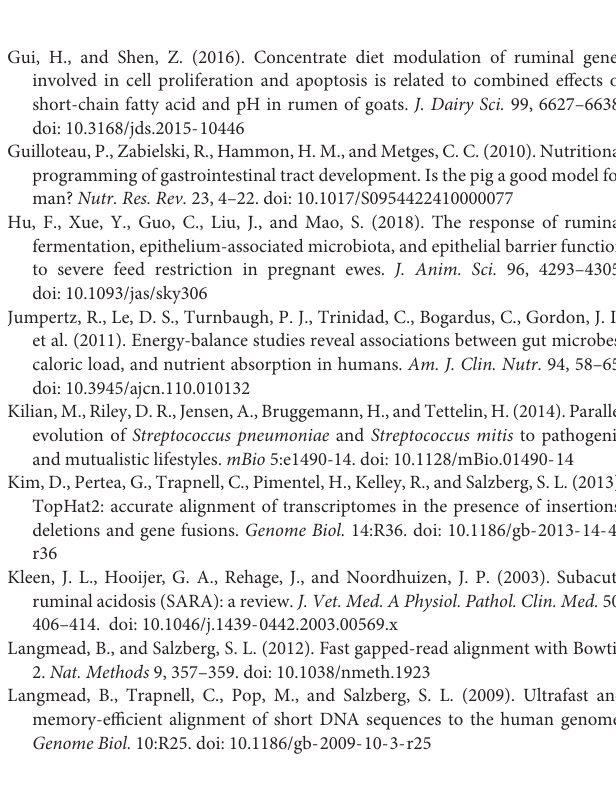
TABLE S1 | Primers used for the RT-QPCR. TABLE S2 | Genera composition and abundances of epimural microbiota. TABLE S3 | KO compositions and abundances of epimural microbiota. TABLE S4 | Gene compositions and abundances in the rumen